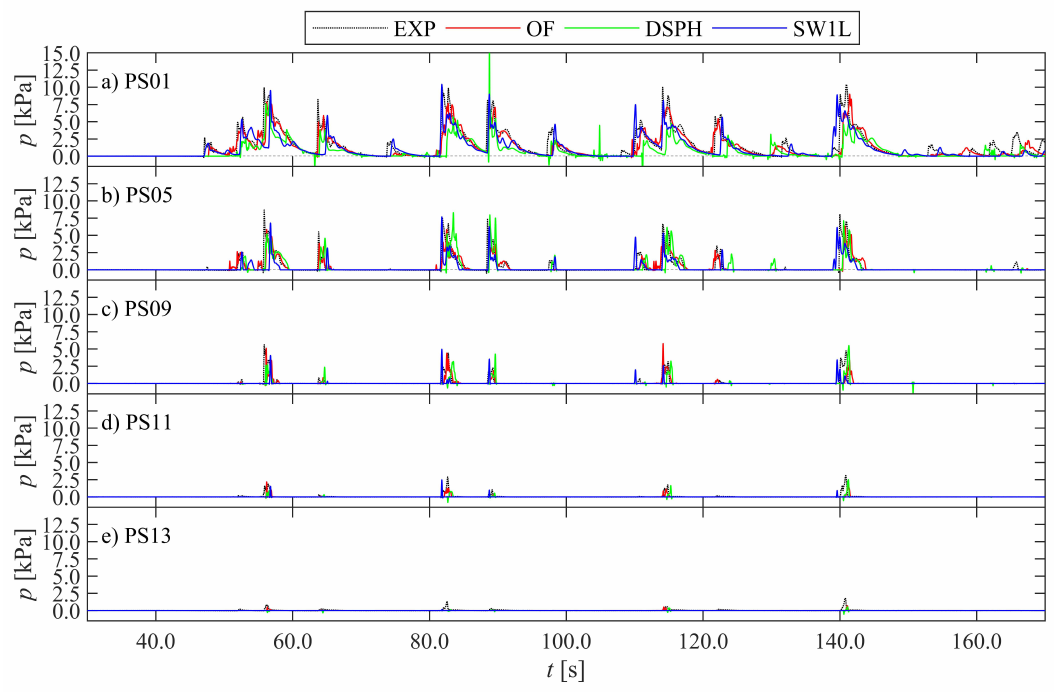
Figure 8. Comparison of the p time series at selected sensor locations ( a – e ), PS01 being the bottom PS ( a ) and PS13 the top-most PS ( e ). Adapted from the work in [3], with permission from the authors,